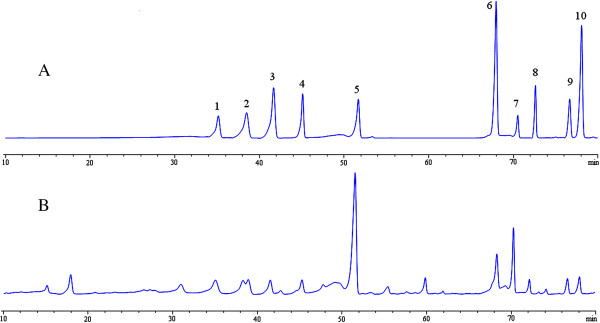
HPLC chromatogram of flavonoid compositions in flavonoid compound (FC). (A) standard flavonoids; (B) FC. Peaks: 1: vitexin; 2: rutin; 3: hyperoside; 4: luteolin-7-O-β-D-glucopyranoside; 5: quercitrin; 6: quercetin; 7: tiliroside; 8: luteolin; 9: apigenin; 10: kaempferol.